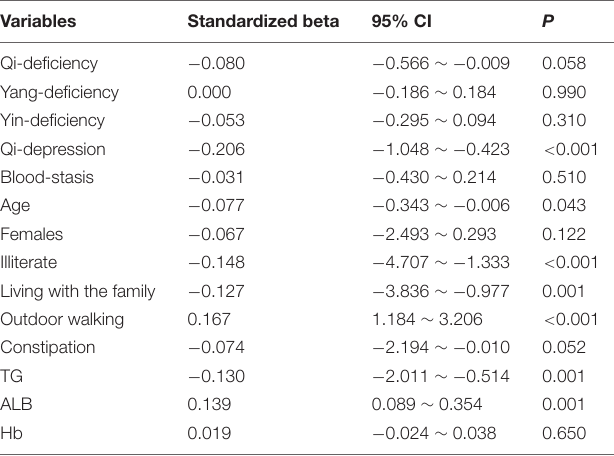
TABLE 3 | Multiple logistic regression analysis between TCM constitution and